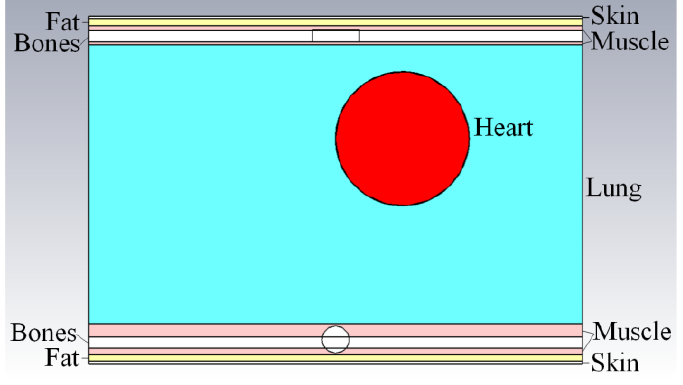
Fig. 1. Structure of the chest area model in CST STUDIO. The electrophysical parameters of tissues and organs in the electrodynamic model of the human chest correspond to the real values of the indicated parameters of the tissues of the human body, which ensures that the simulation results are close to the real conditions observed during the experimental